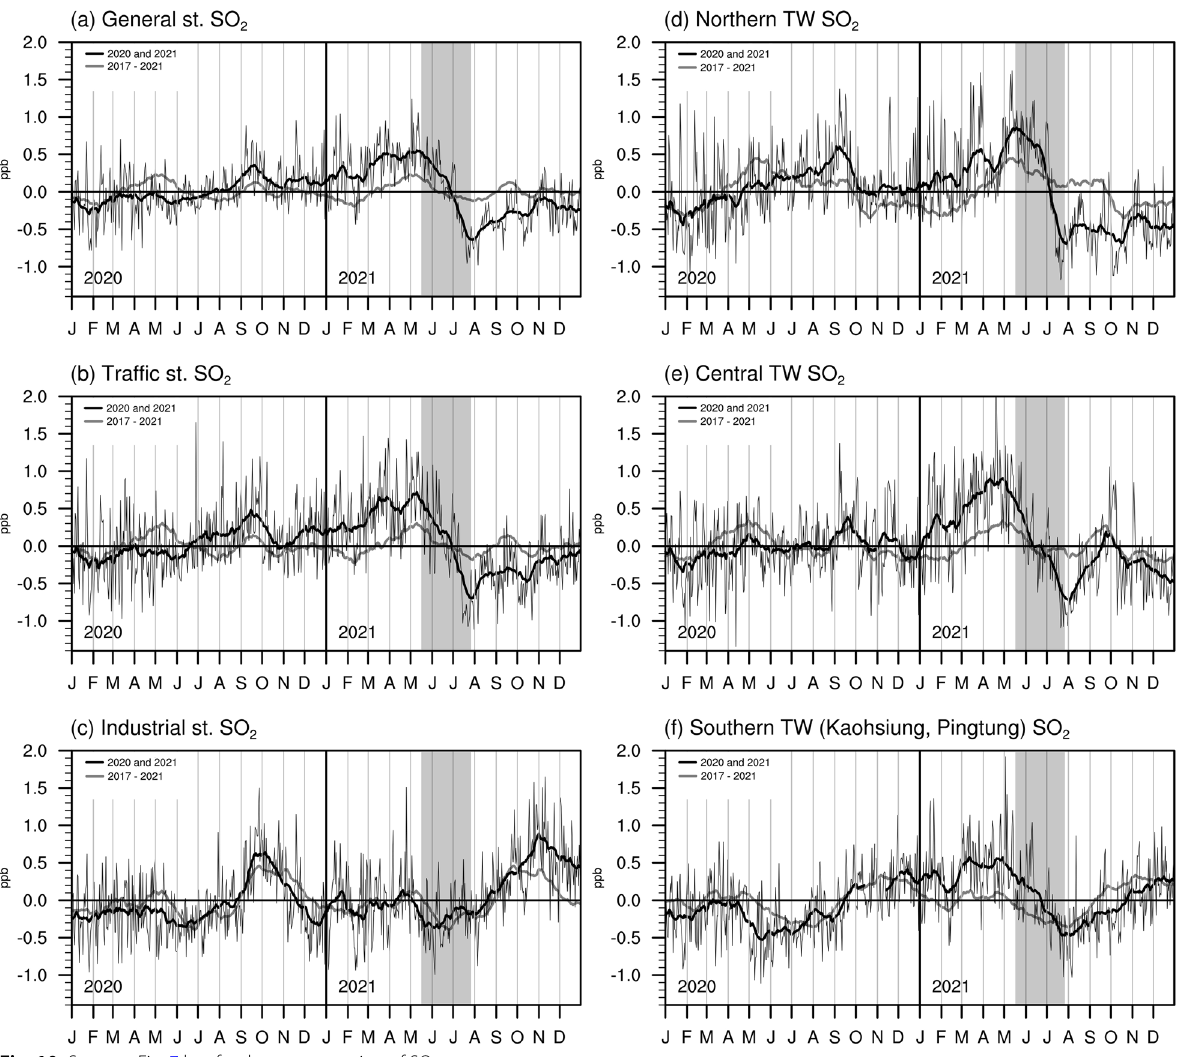
Fig. 10 Same as Fig. 7 but for the concentration of SO